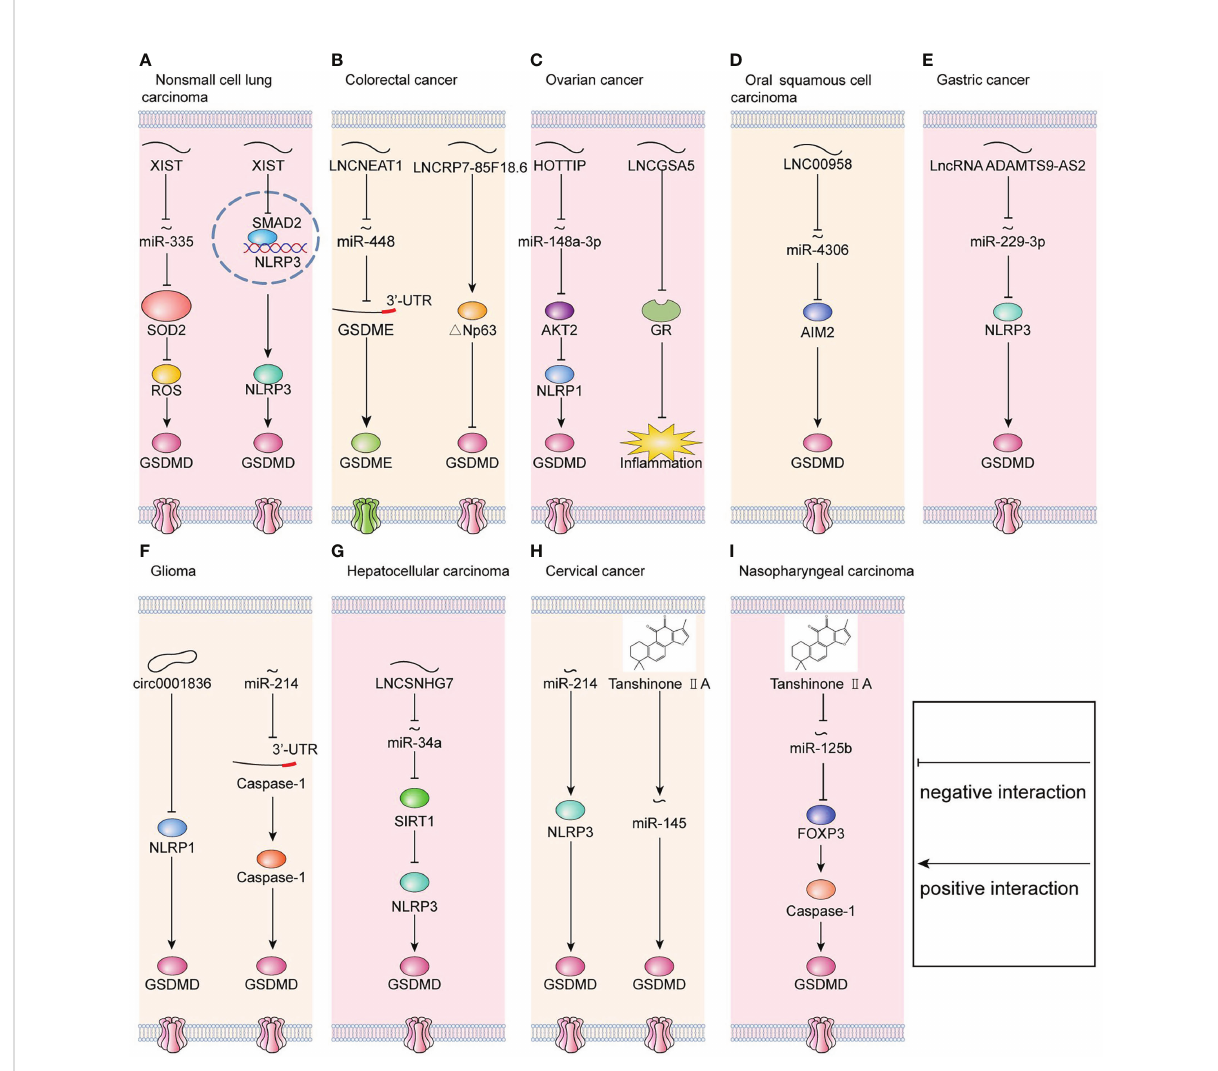
FIGURE 1 Molecular mechanisms that regulate pyroptosis in cancers. (A) In non-small cell lung carcinoma, LNCXIST regulates pyroptosis via the miR-335/ SOD2 axis and SMAD2/NLRP3 axis simultaneously. (B) In colorectal cancer, LNCNEAT1 regulates pyroptosis via the miR-448/GSDME axis, and LNCRP7-85F18.6 regulates pyroptosis via △ Np63. (C) In ovarian cancer, LNCHOTTIP regulates pyroptosis via the miR-148a-3p/AKT2/NLRP1 axis. Meanwhile, LNCGSA5 interferes with glucocorticoid receptor (GR), which blocks the upregulation of anti-in fl ammatory proteins and eventually promotes in fl ammasome formation. (D) In oral squamous cell carcinoma, LNC00958 regulates pyroptosis via the miR-4306/AIM2 axis. (E) In gastric cancer, LncRNA ADAMTS9-AS2 regulates pyroptosis via the miR-229-3p/NLRP3 axis. (F) In glioma, downregulation of circ0001836 promotes pyroptosis via epigenetically upregulating NLRP1. Meanwhile, miR-214 directly binds to the 3 ’ -UTR of caspase-1 and consequently inhibits pyroptosis. (G) In hepatocellular carcinoma, LNCSNHG7 regulates pyroptosis via the miR-34a/SIRT1 axis. (H) In cervical cancer, miR-214 regulates pyroptosis via targeting to NLRP3. Moreover, tanshinone IIA promotes pyroptosis via upregulating miR-145. (I) In nasopharyngeal carcinoma, tanshinone IIA regulates pyroptosis via the miR-125b/FOXP3